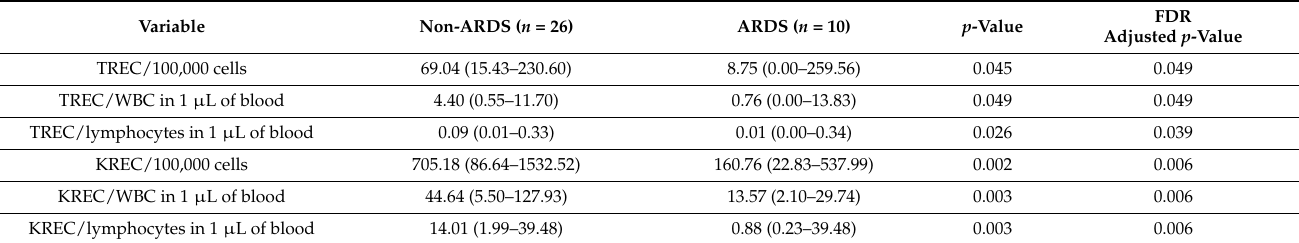
Table 2. Comparison of TREC/KREC levels between ARDS and non-ARDS COVID-19 patients.